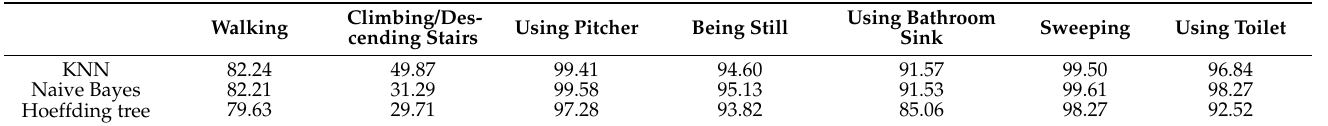
Table 4. Performance of the algorithms in the classification of each activity.